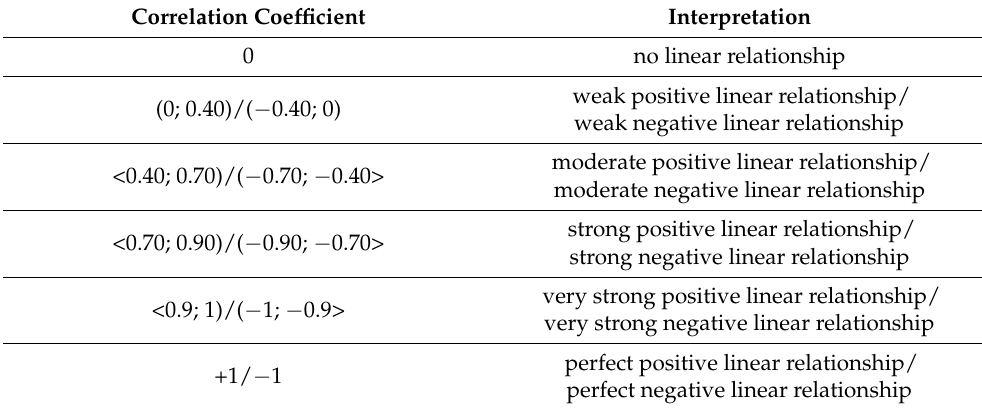
Table 2. The interpretation of the correlation coefficient.